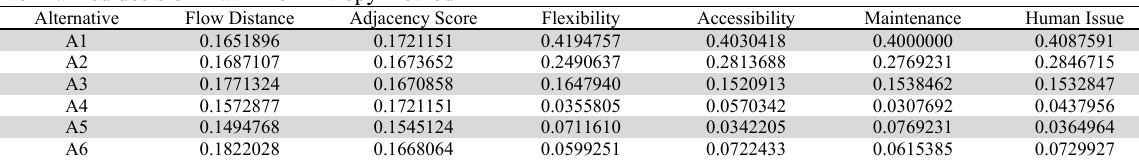
Normalized decision matrix for Entropy method